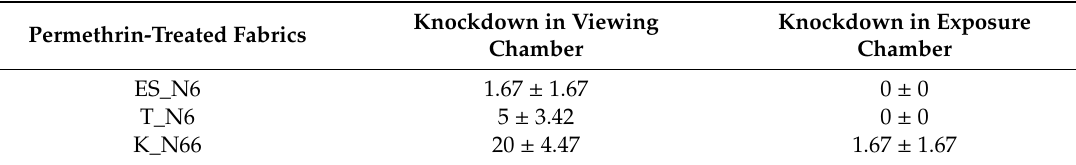
Table 5. Sublethal e ff ects other than repellency caused by various permethrin-treated fabrics after a five-minute exposure